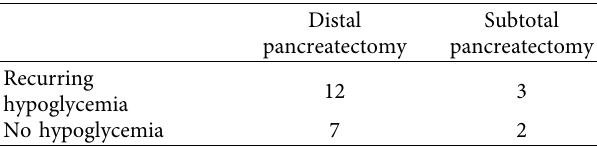
Table 2: Selected previously reported cases of idiopathic nesi- dioblastosis with follow-up after surgery [7, 11, 19–27]. Distal pancreatectomy refers to the removal of the body and tail of the pancreas, typically no more than 60%. Subtotal pancreatectomy refers to removal of approximately 80% of the